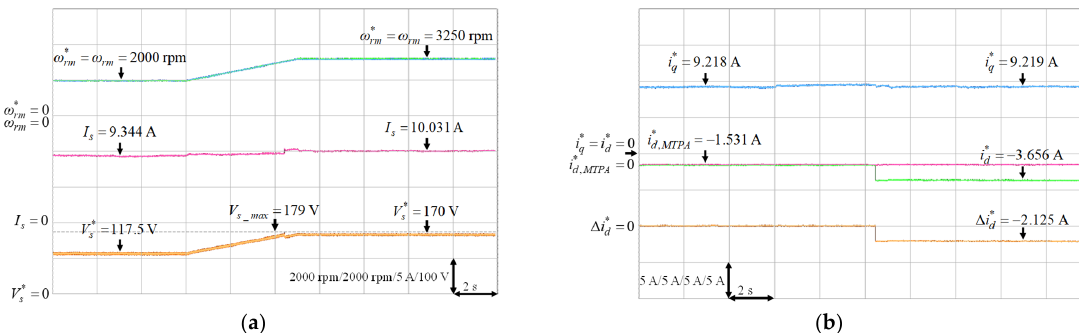
Figure 21. Experimental results of FW control from 2000 rpm to 3250 rpm under 5.85 Nm load torque: ( a ) Mechanical speed command, mechanical speed, stator current and stator voltage command; ( b ) q -axis current command, d -axis current command of MTPA, d -axis current command and variation of d -axis current command.